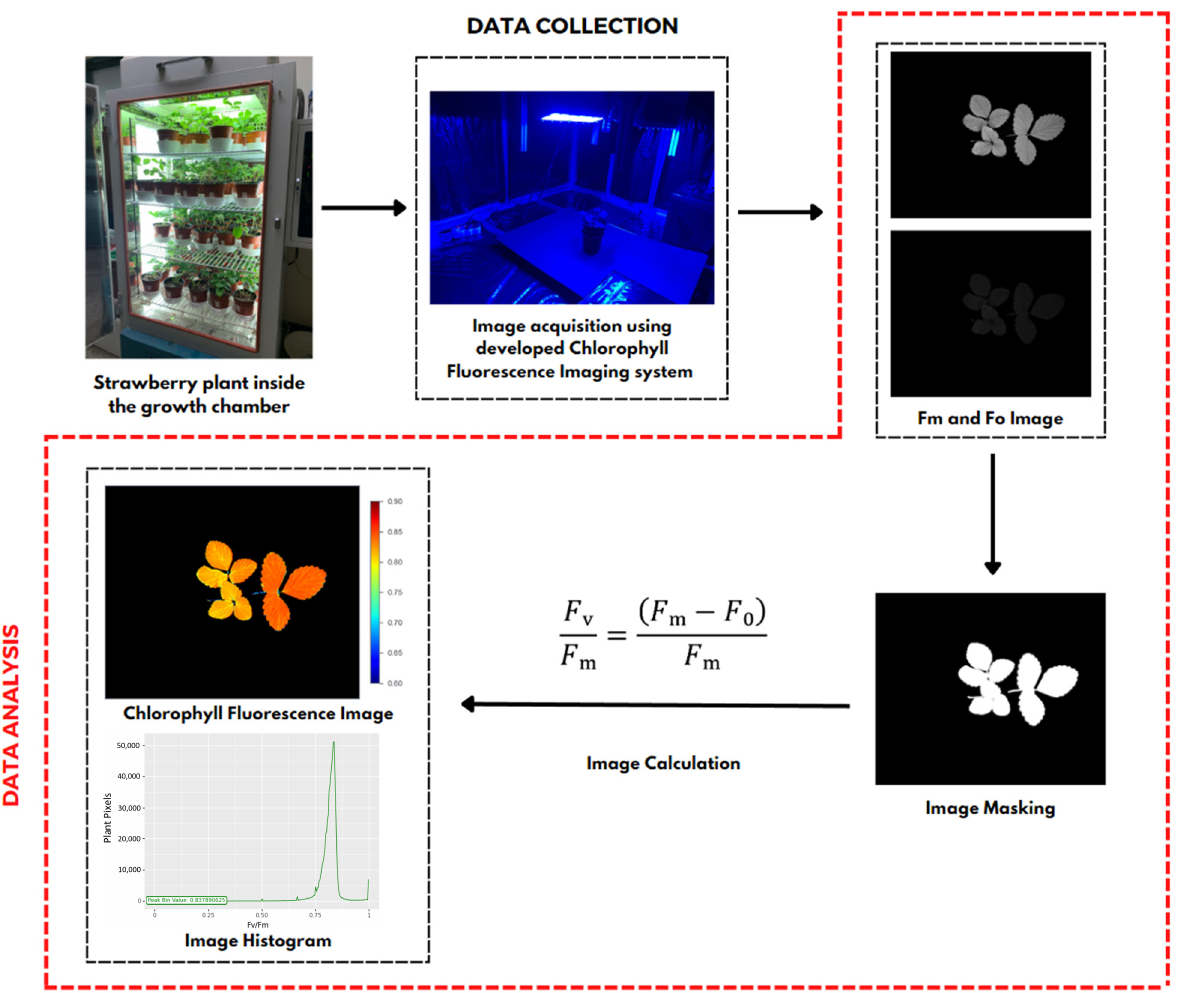
Figure 3. Workflow to develop chlorophyll fluorescence image. The Fm and Fo images captured using the developed system are processed computationally, which includes masking and calculating the chlorophyll fluorescence parameters to generate chlorophyll fluorescence images along with their histogram images.